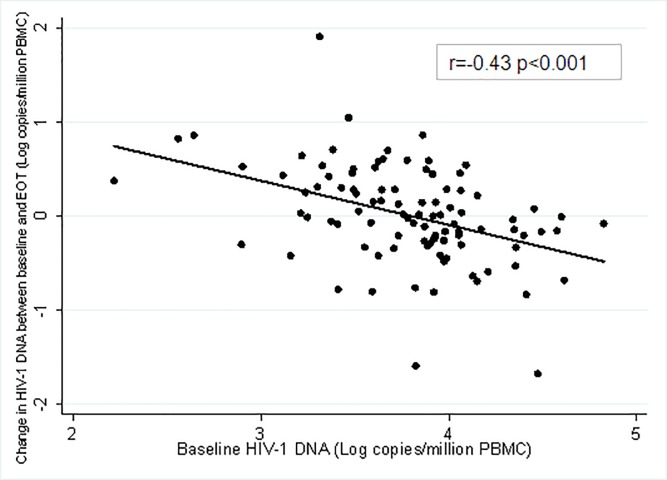
The scatterplot of baseline HIV-1 DNA levels and change between EOT and baseline.